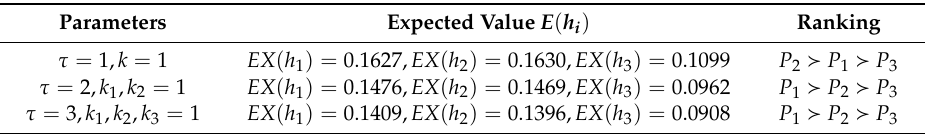
Table 4. Ranking results with di ff erent parameter τ